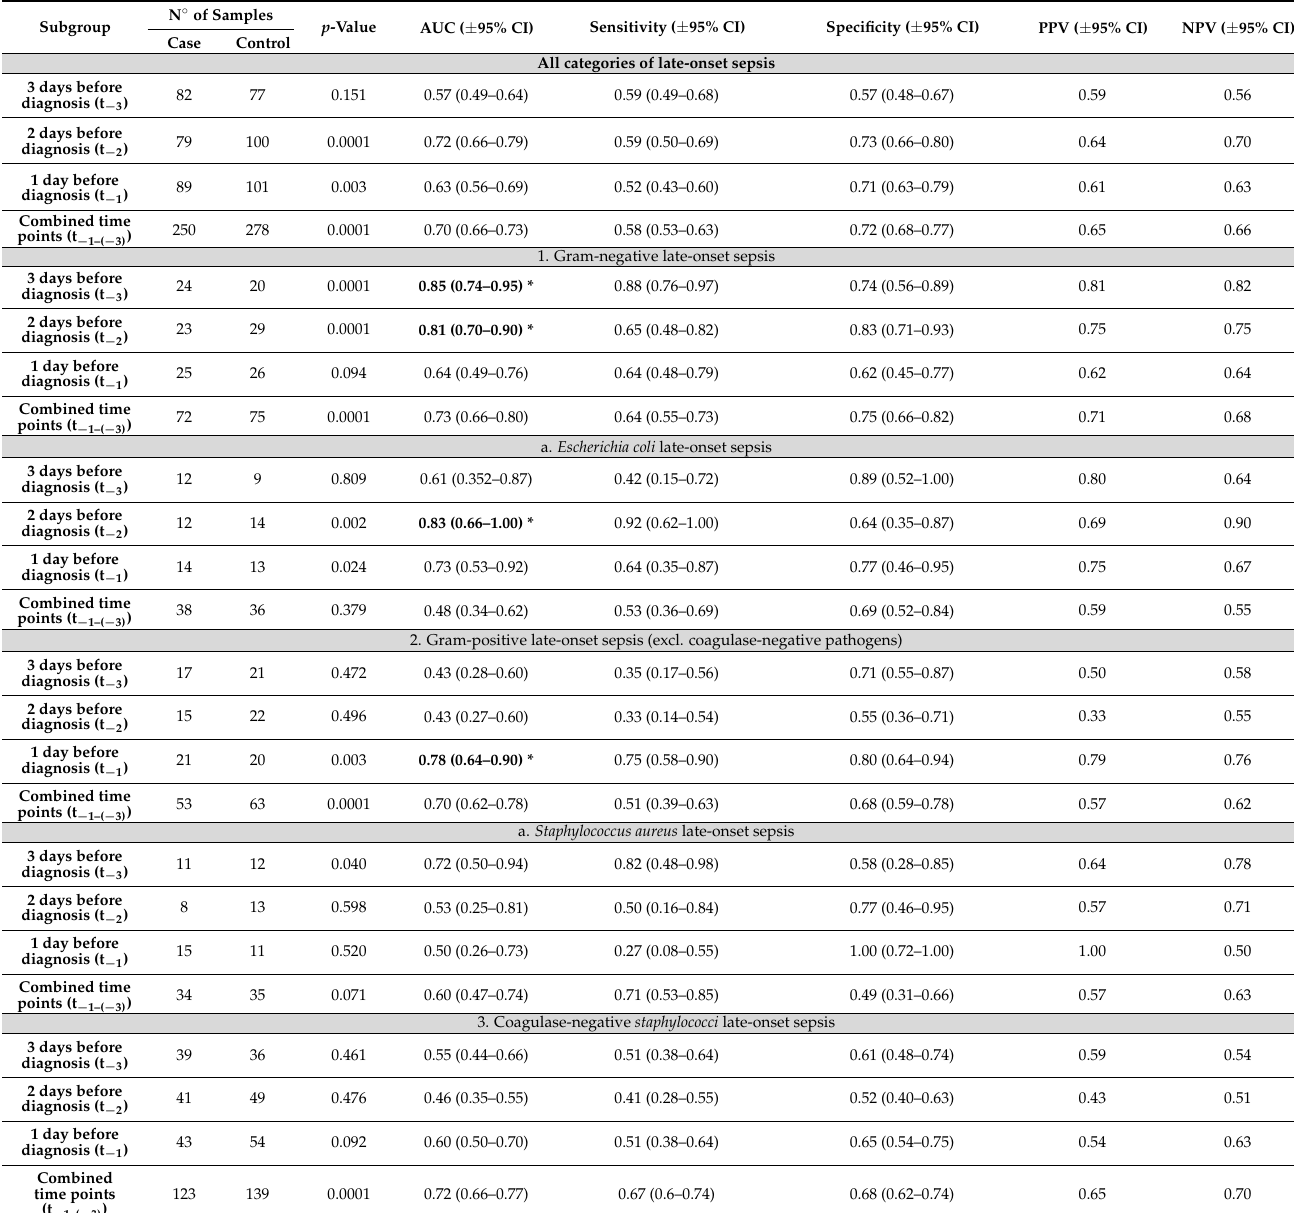
Table 2. Performance characteristics of gas chromatography—ion mobility spectrometry, as analyzed by sparse logistic